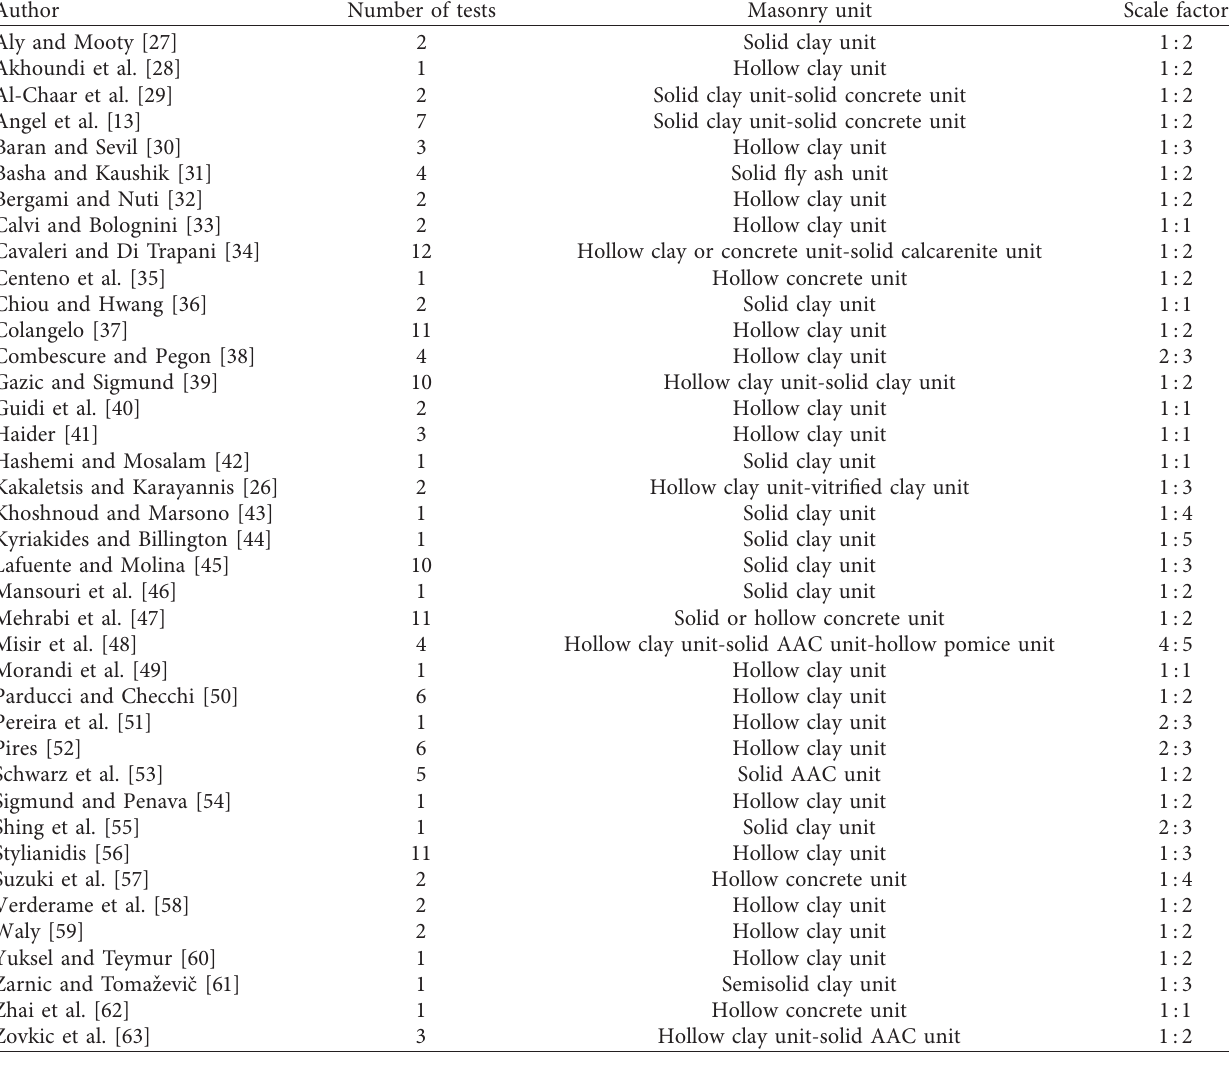
Table 1: Literature review of IP experimental tests of infill walls depending on infill material typology: subset of tests on 1-bay 1-storey frames infilled without opening (adapted from [4]).